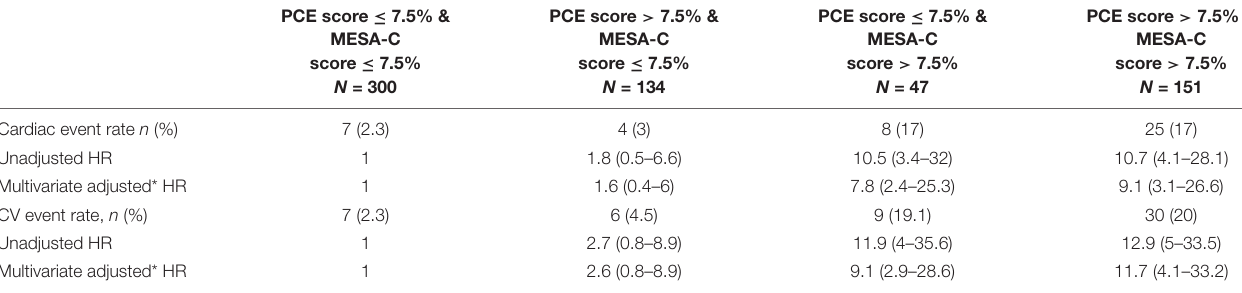
TABLE 3 | HR for cardiac events as well as total cardiovascular events according to the cardiovascular risk score